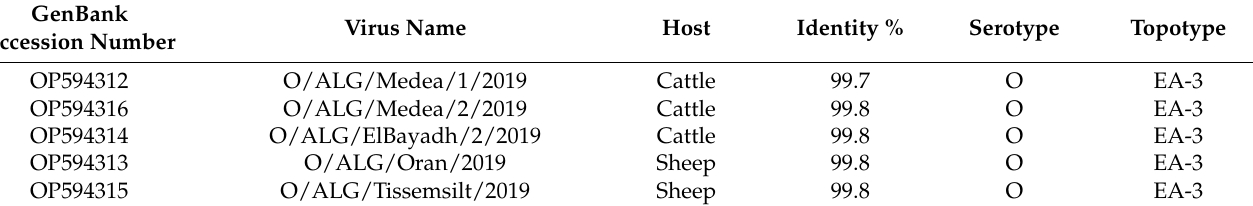
Table 4. Most closely related sequences of Algerian FMD isolates to the Libyan isolate.